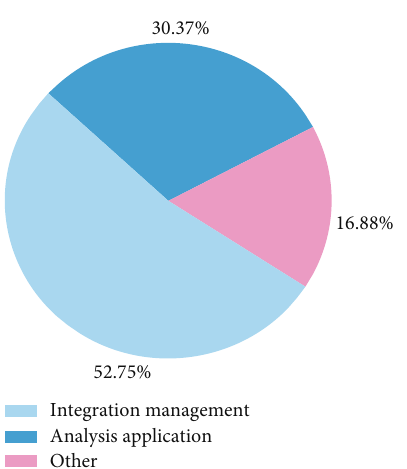
Figure 3: China ’ s investment in Central Asia big data segment industry market structure